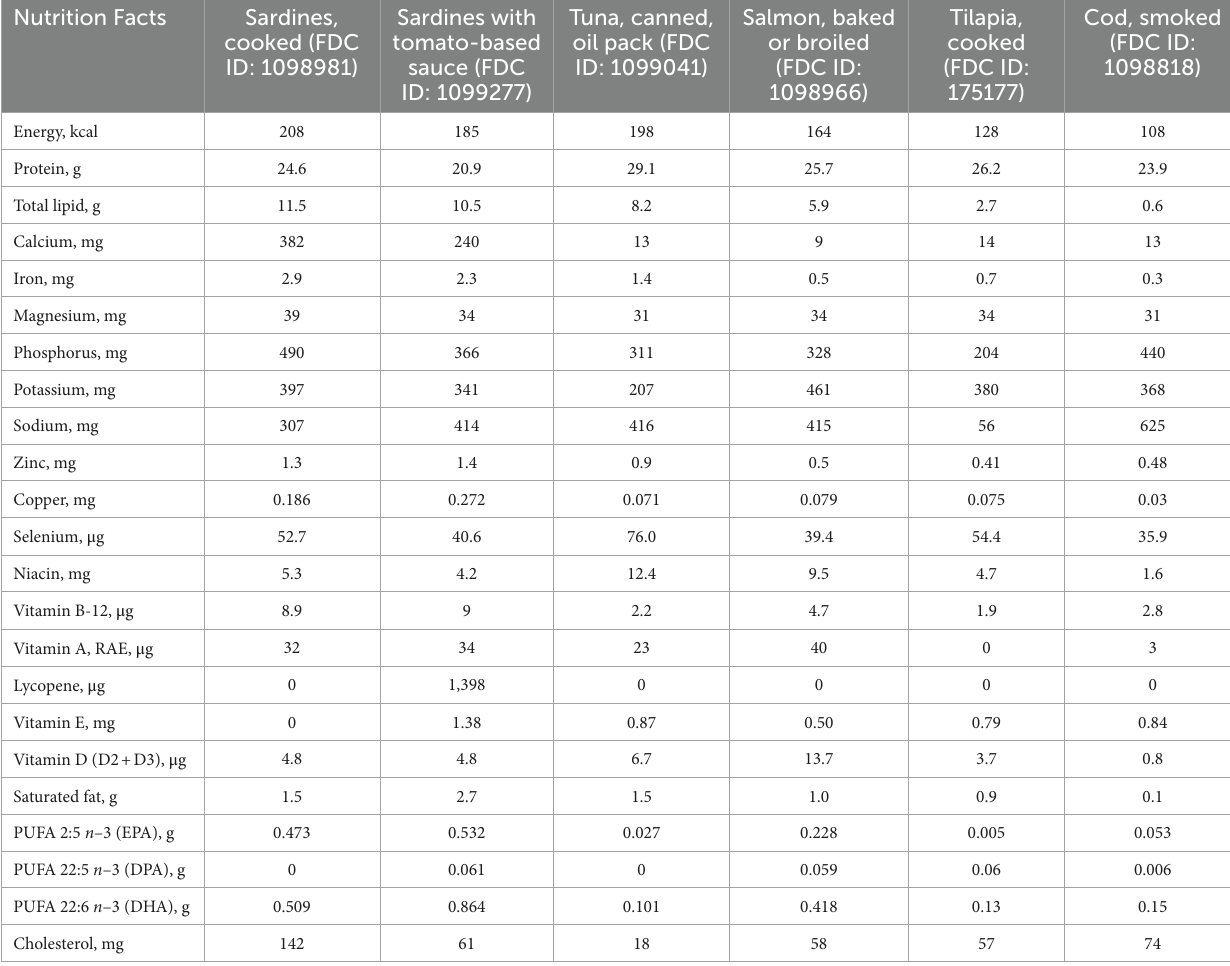
TABLE 1 Nutrition facts of sardines compared with other popular fish (values per 100 g). Nutrition